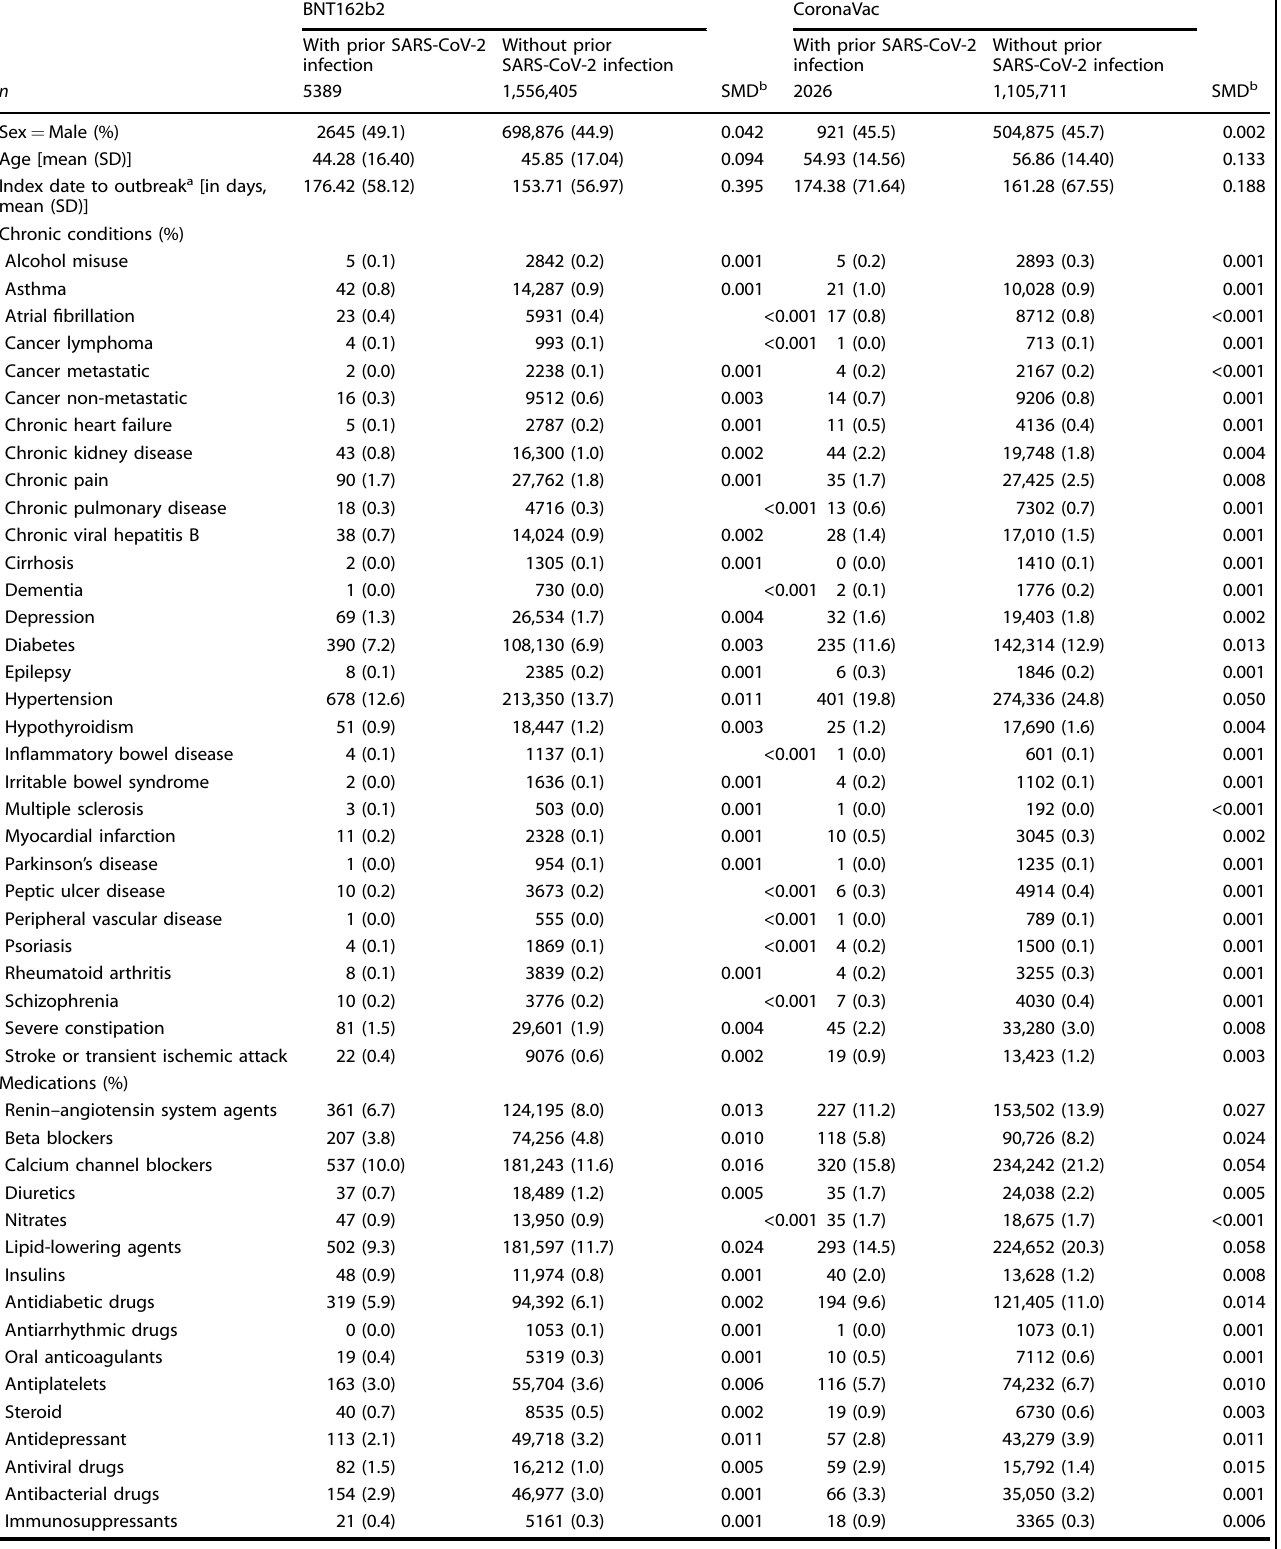
Table 1. Baseline characteristics of two-dose vaccine recipients without prior infection and one-dose recipients with prior